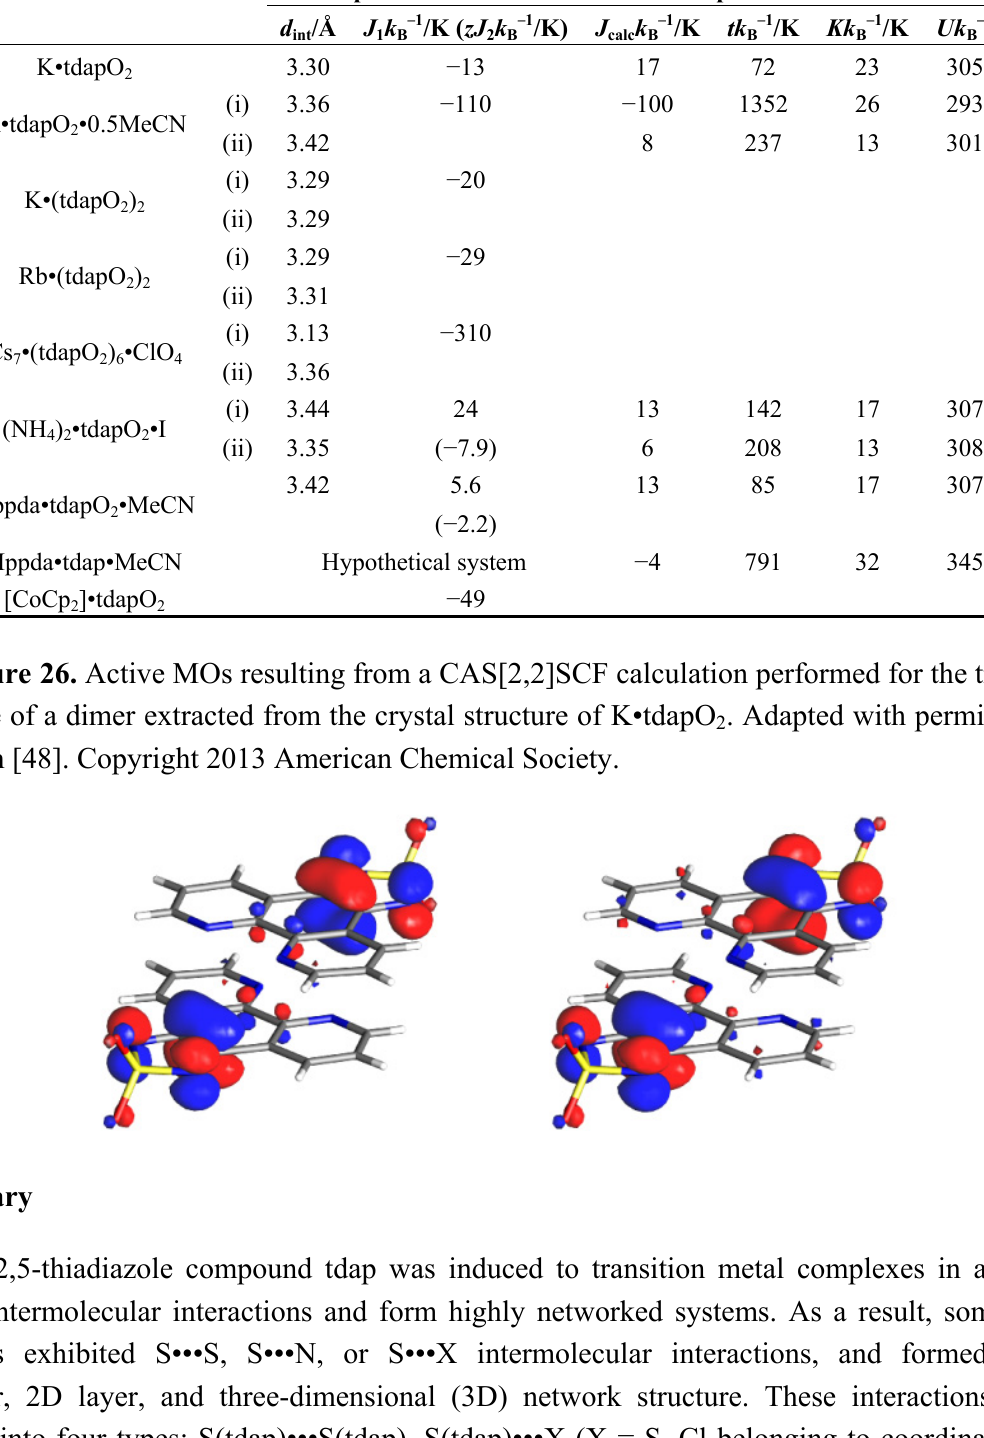
Table 2. Interplanar distances ( d from the theoretical fits of experimental data, and J parameters from DDCI calculations performed on radical anion pairs. Adapted with permission from [48]. Copyright 2013 American Chemical Society.